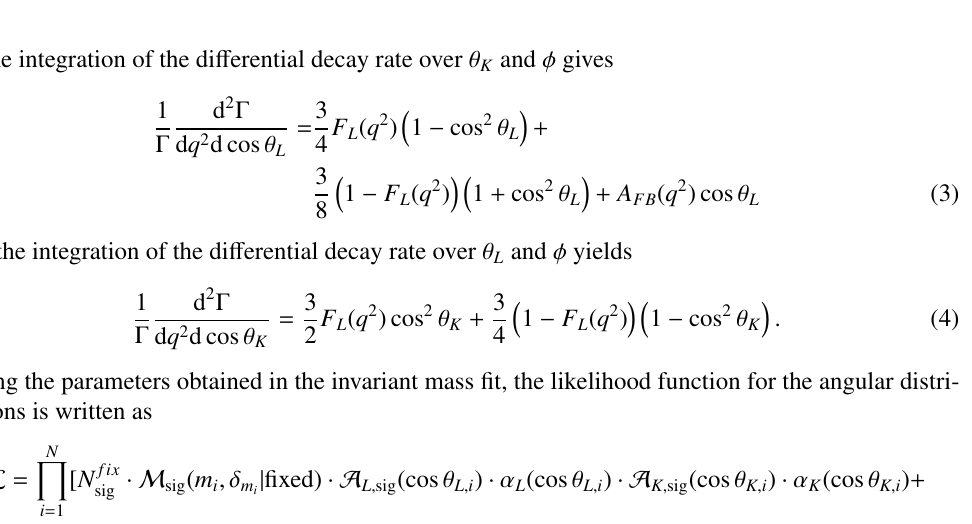
Figure 4. (a) Forward-backward asymmetry A FB and (b) fraction of longitudinally polarised K ∗ 0 mesons, F L , including statistical and systematic uncertainties, compared to theoretical predictions calculated for the limits of small and large values of q 2 including theoretical uncertainties [5]